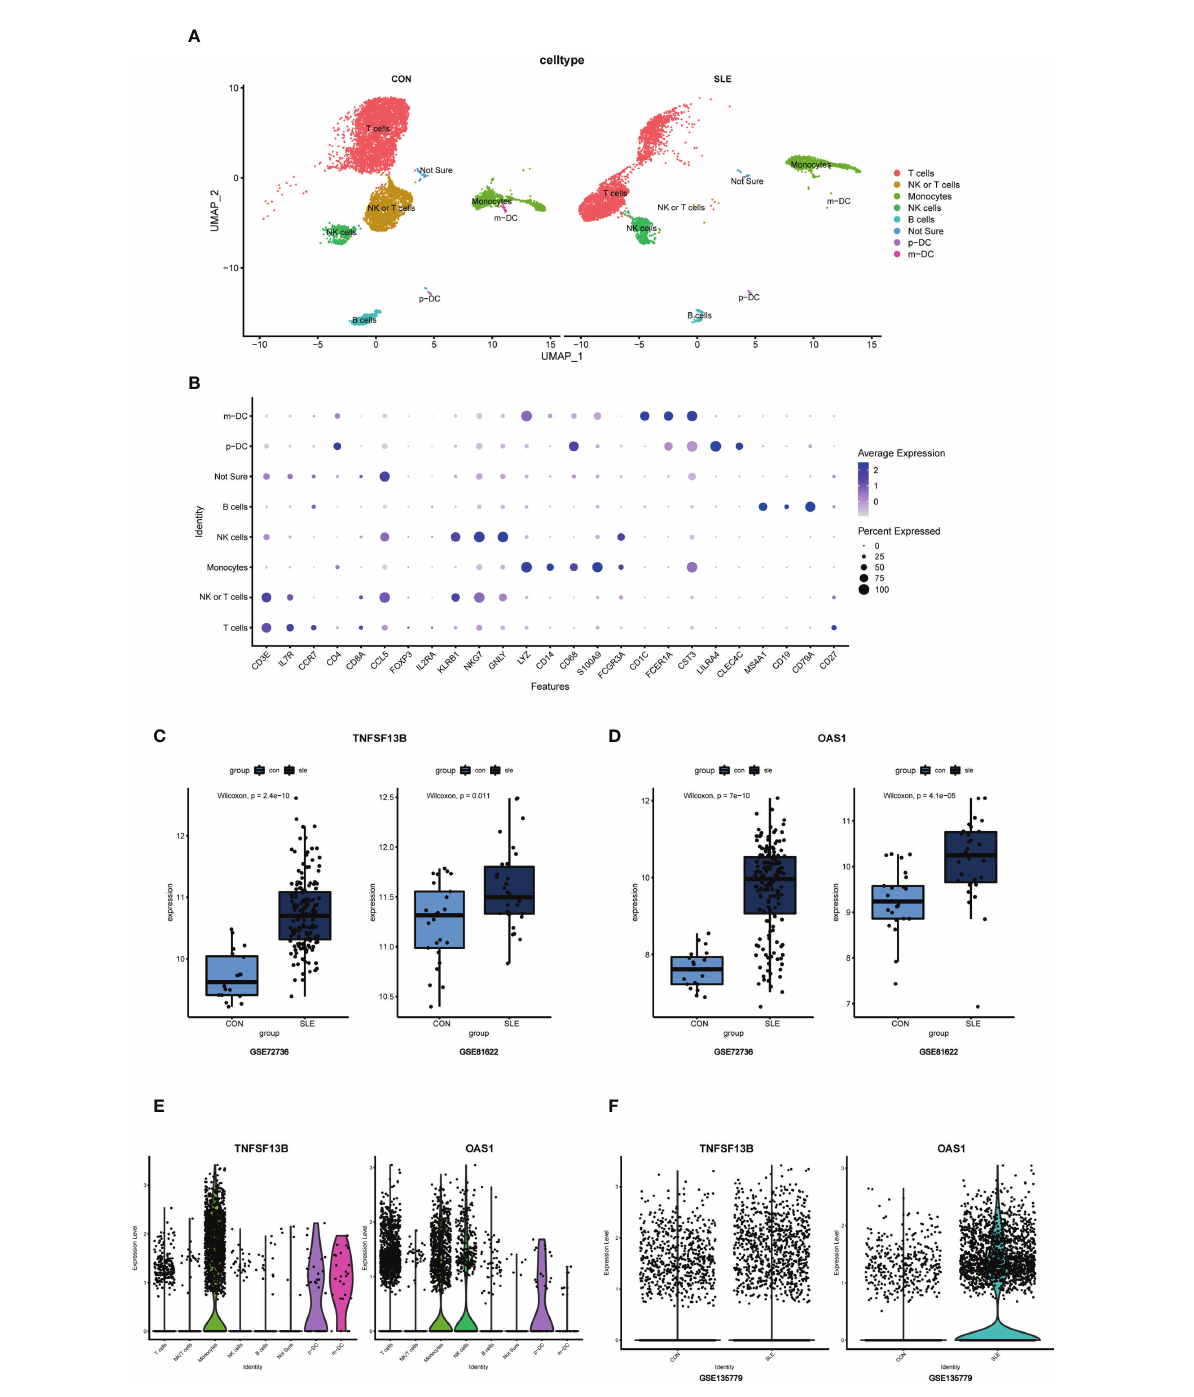
FIGURE 10 (A) UMAP visualization of the 11178 cells in the single-cell RNA seq dataset GSE135779; Different colors indicate distinct clusters; m-DC: myeloid dendritic cells; p-DC: plasmacytoid dendritic cells. (B) Dot plot of cell population annotation based on different signatures. (C) Boxplots of TNFSF13B expression levels in GSE72326 and GSE81622; Comparison was conducted by Wilcoxon rank-sum test. (D) Boxplots of OAS1 expression levels in GSE72326 and GSE81622; Comparison was conducted by Wilcoxon rank-sum test. (E) The expression level of TNFSF13B and OAS1 in 8 clusters of cells in GSE135779. (F) The expression level of TNFSF13B and OAS1 in controls and SLE patients in